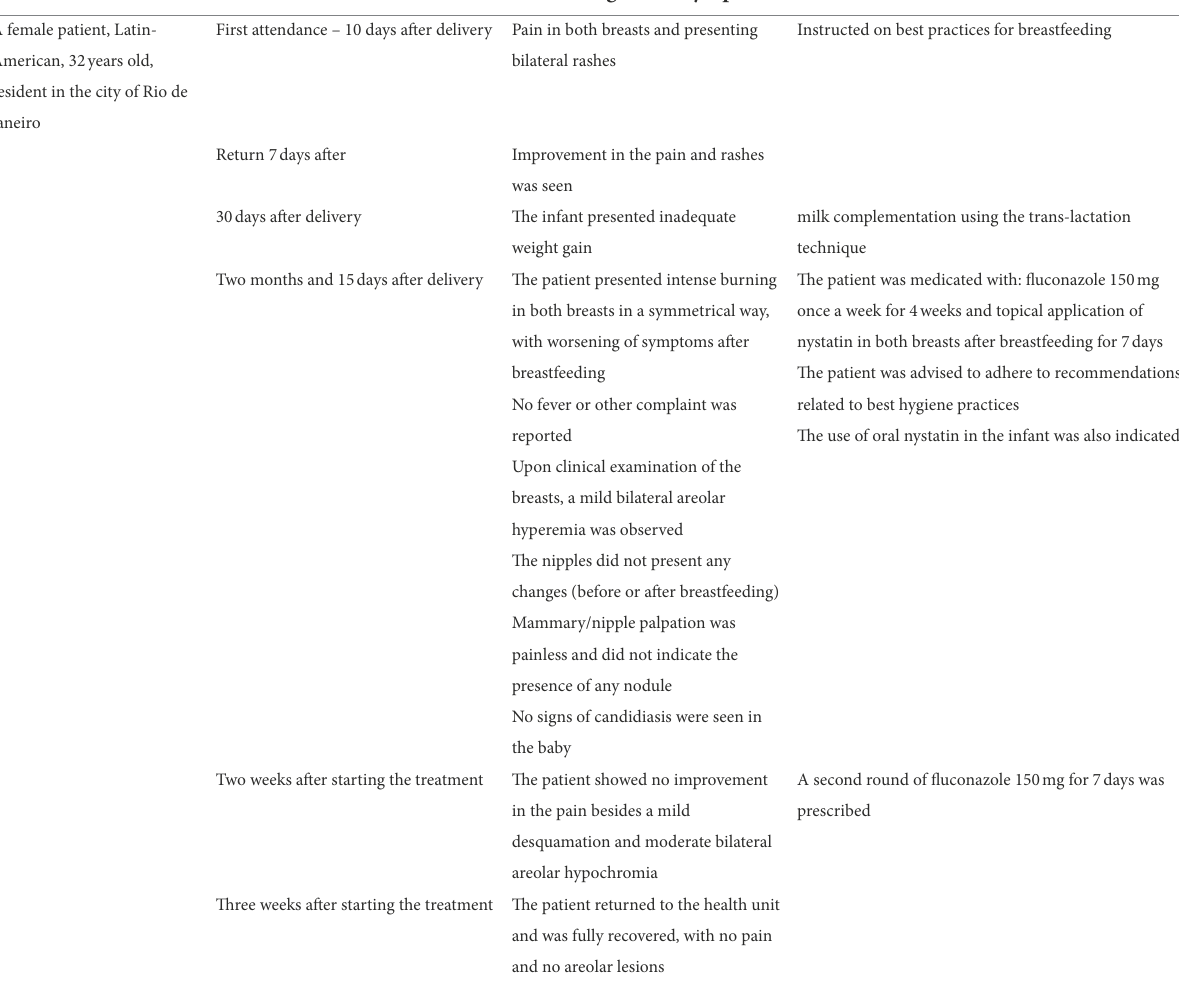
TABLE 1 Timetable of patient’s symptoms and